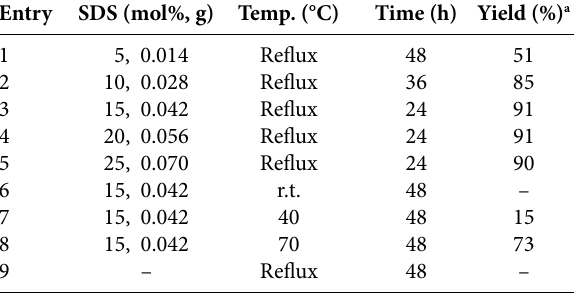
Table 1. The one-pot condensation reaction between isatin ( 1a ) (1 mmol, 0.147 g), 5,5-dimethylcyclohexane-1,3-dione ( 2a ) (1 mmol, 0.140 g) and cyclohexyl isocyanide ( 3a ) (1 mmol, 0.109 g) in the presence of SDS as a surfactant in water (5 mL) under various reac- tion conditions.